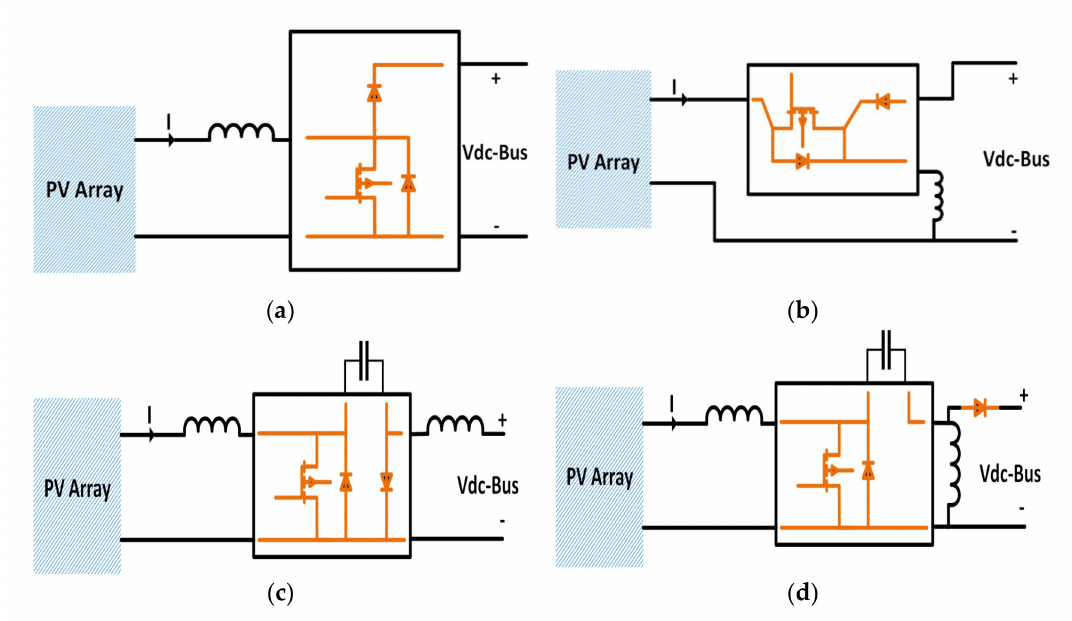
Figure 6. Schematic diagram of non-isolated DC–DC converters. ( a ) Boost converter; ( b ) buck-boost converter; ( c ) Cuk converter; ( d ) single-ended primary-inductor converter (SEPIC) [29,60].